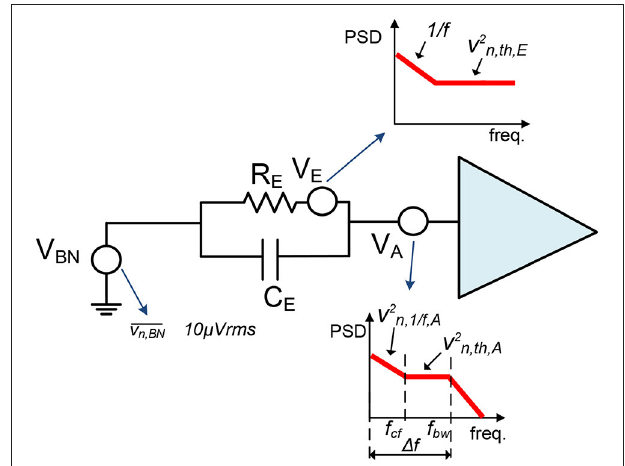
FIGURE 3 | Simplified scheme of the three main noise sources at the Electrode-AFE interface: the biological or background noise (VBN), the electrode noise (VE), and the noise from the recording electronics